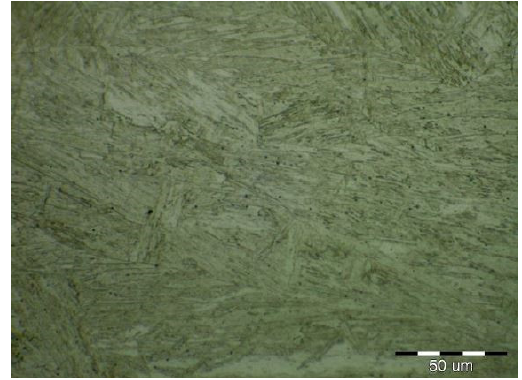
Figure 14. Weld metal microstructure of sample B (DP600).